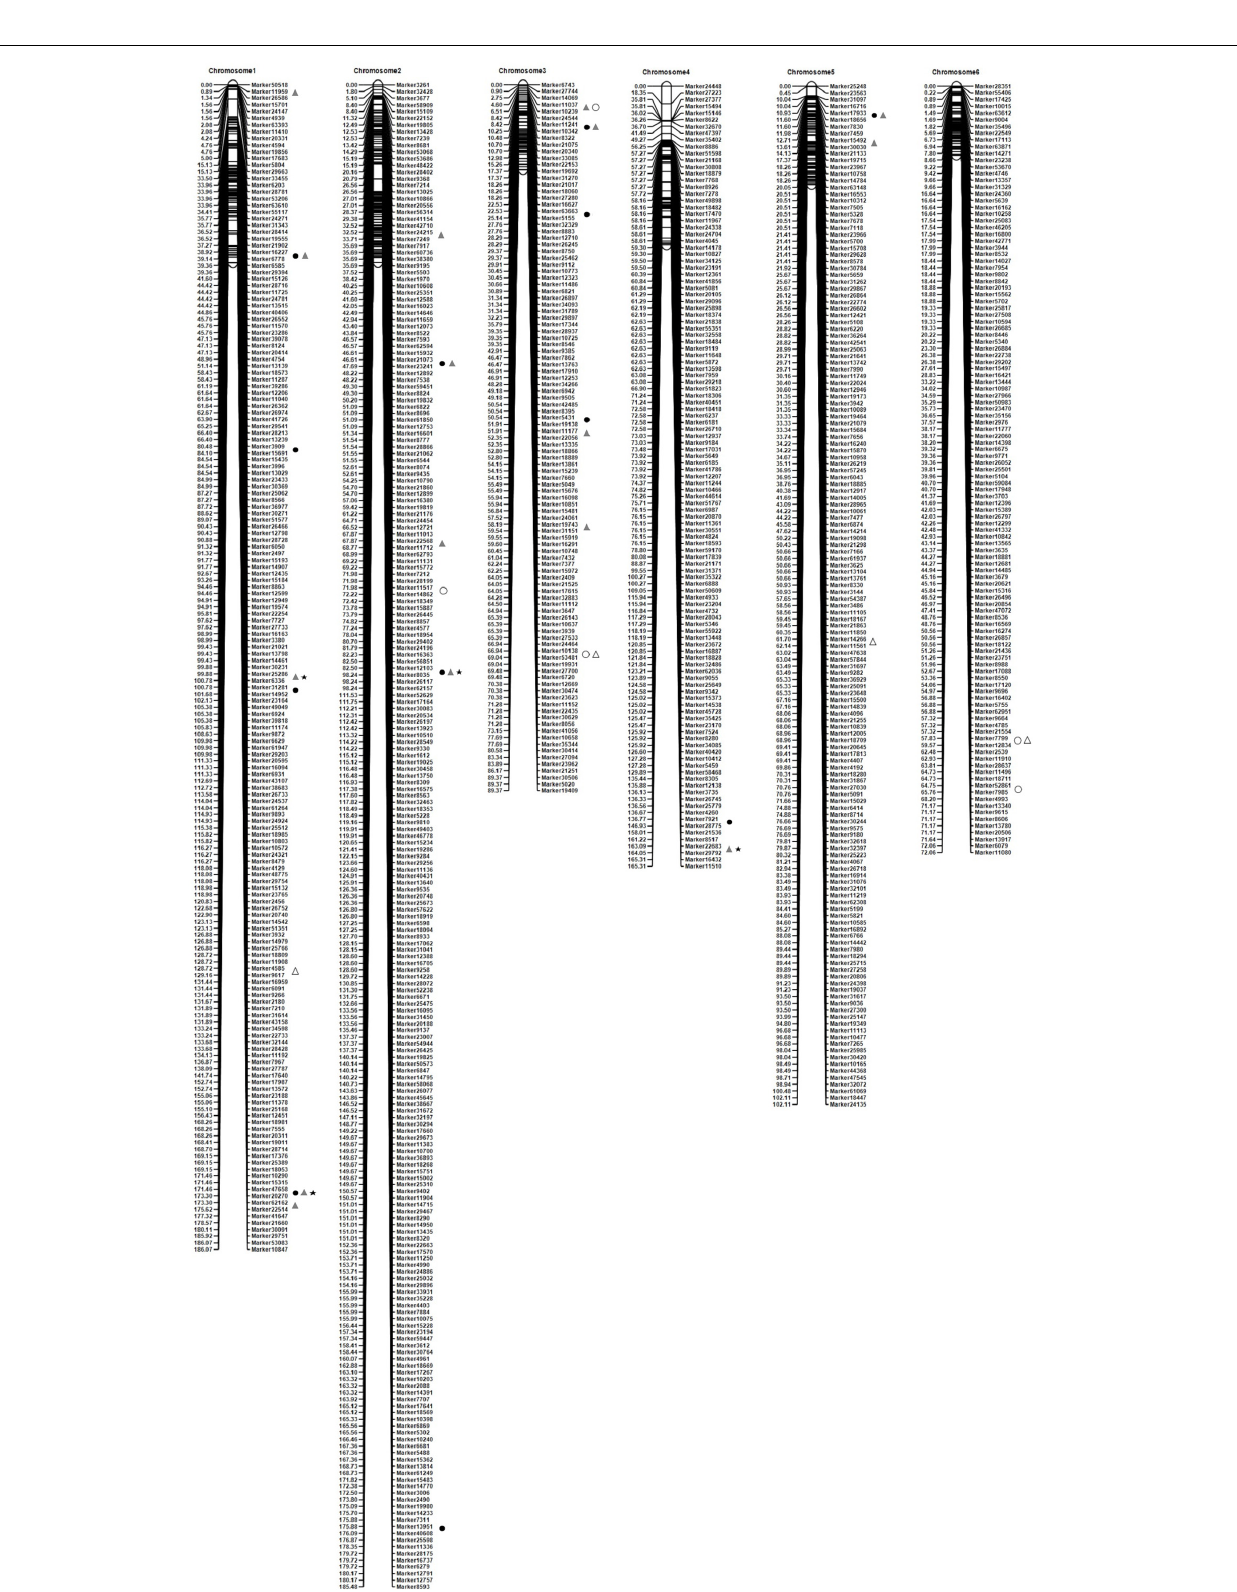
FIGURE 2 | Dynamic identifications of quantitative trait loci (QTLs) controlling TN in different periods in the Agropyron CP hybrid population. QTL; (cid:13) , no-major unconditional QTL; (cid:78) , major conditional QTL; (cid:77) , no-major conditional QTL; (cid:70) , QTL detected in 2